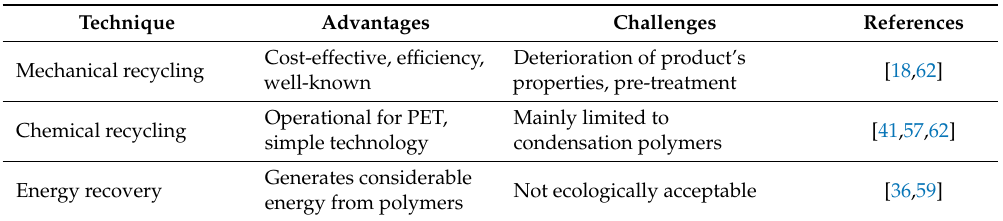
Table 2. Summary of discussed techniques for recycling.